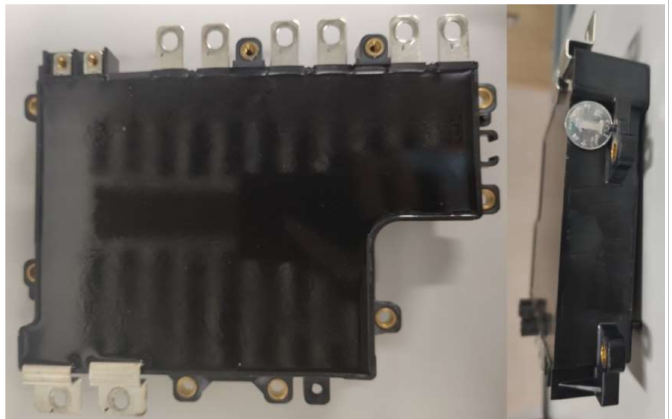
Figure 2. A low-type